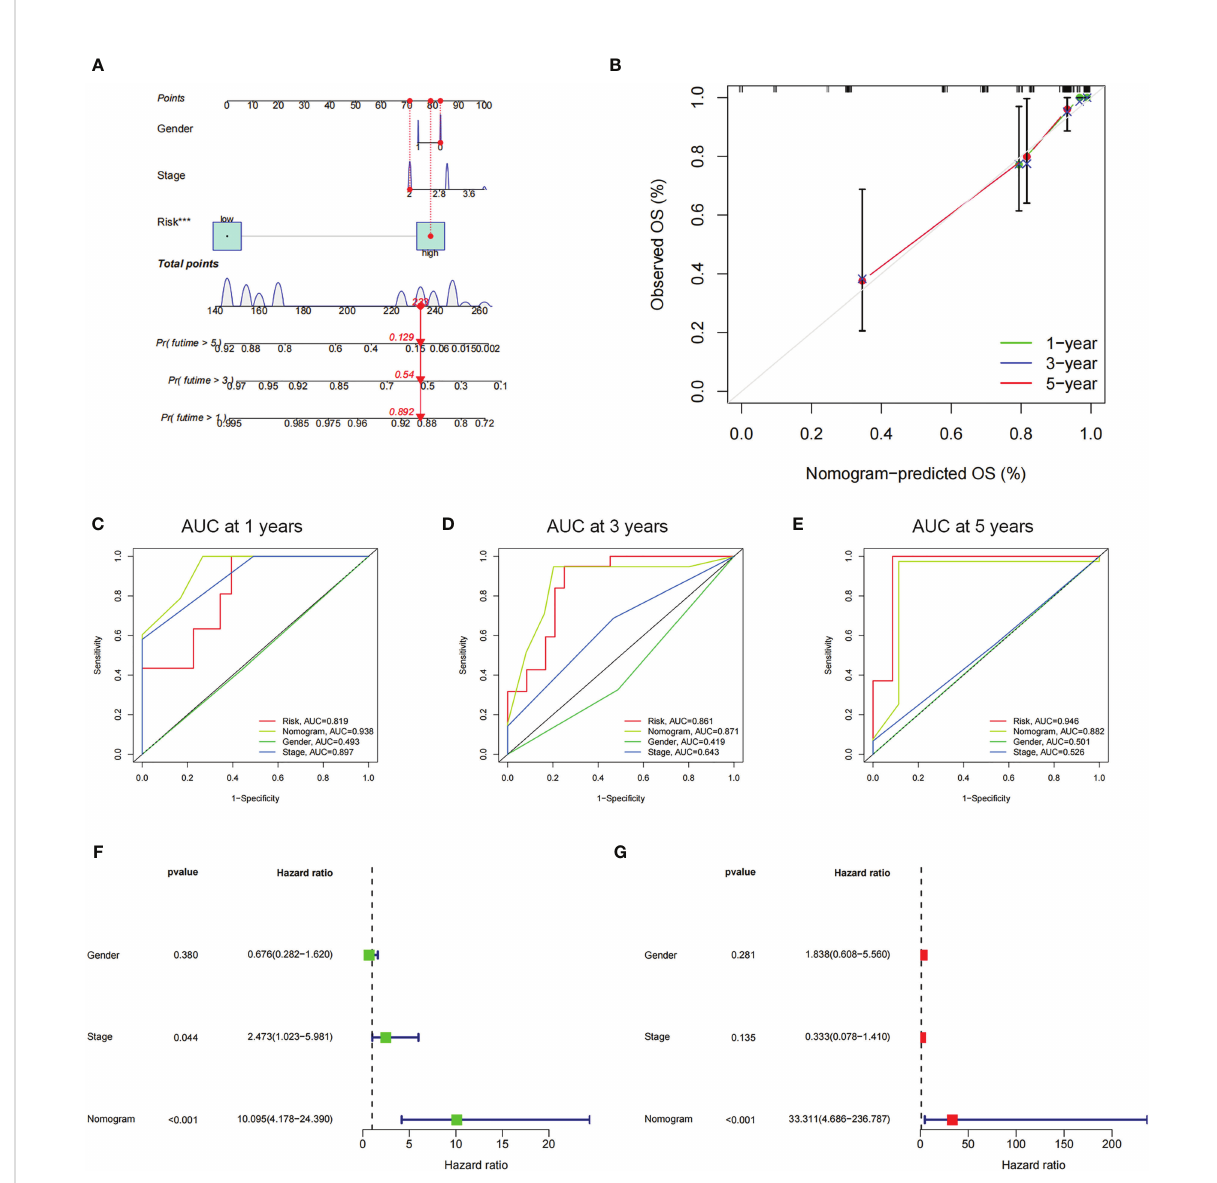
FIGURE 7 The prognostic value of risk score combined with clinicopathological features for OS of patients from the TCGA database. (A) The nomogram shows the OS of the UM patients from the TCGA database. (B) The nomogram ’ s calibration plots. The y-axis represents actual survival, whereas the x-axis represents nomogram-predicted survival. (C-E) ROC curve of risk scores and clinicopathological factors for predicting 1- (C) , 3- (D) , and 5-years (E) OS in UM patients. (F, G) The nomogram ’ s univariate and multivariate Cox regression